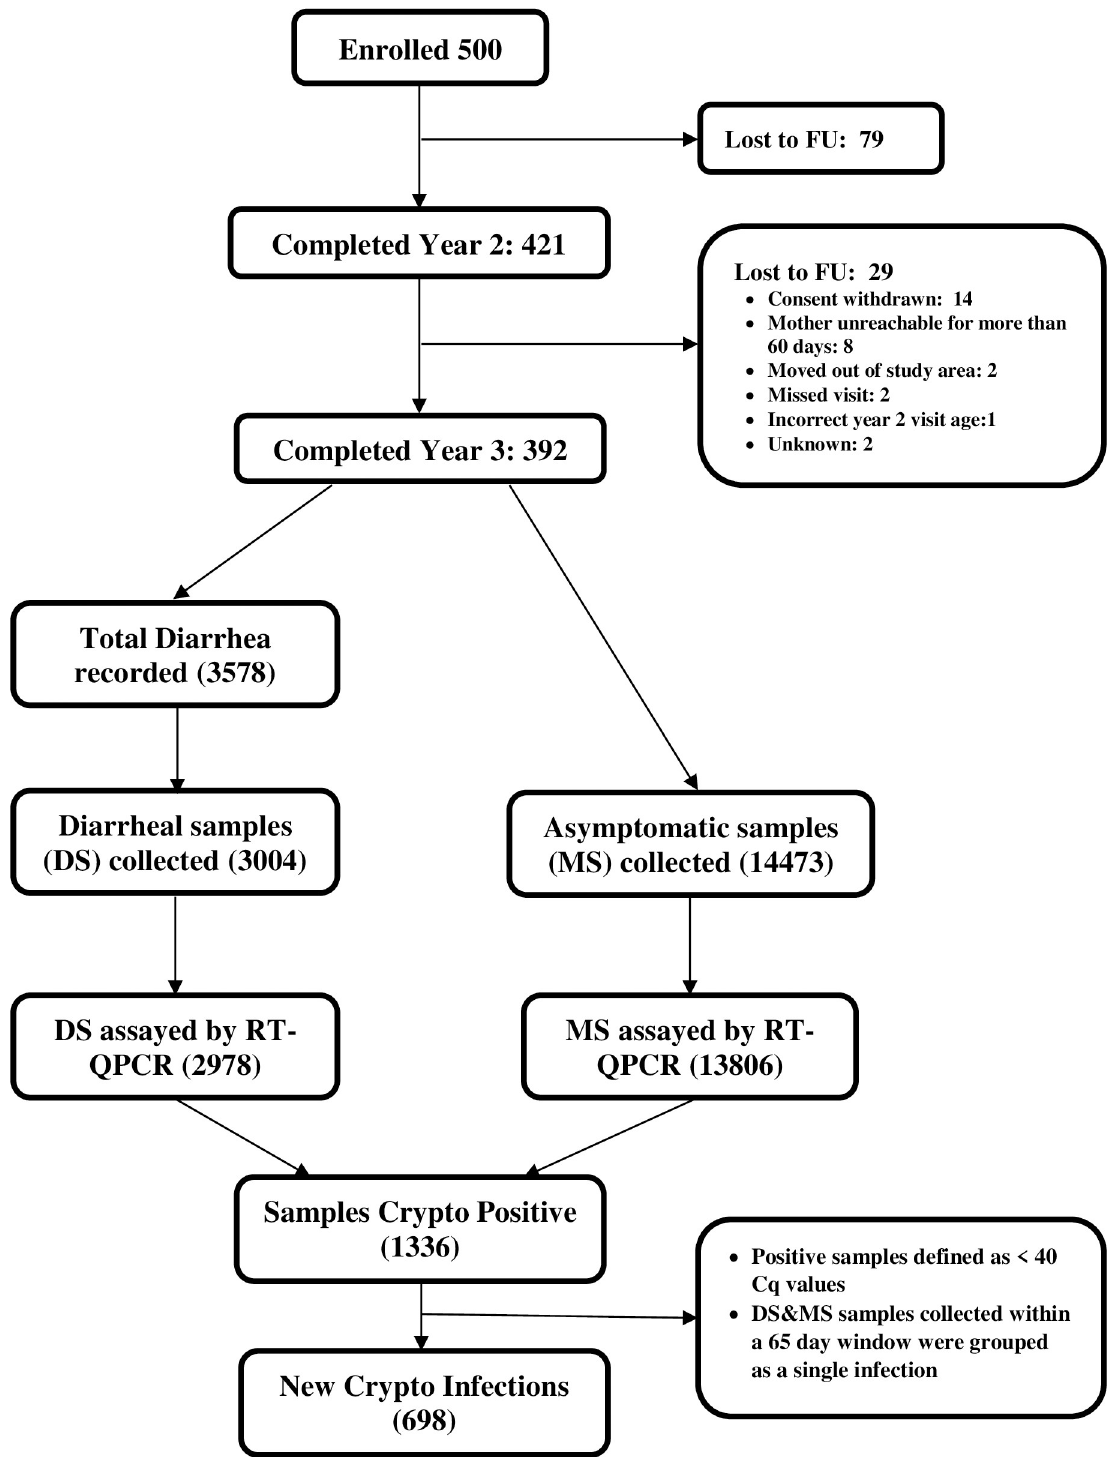
Fig 1. COHORT diagram. Study subjects, collected samples and new infection numbers. Abbreviations: RT-qPCR Real-Time quantitative polymerase chain reaction; DS: Diarrheal Stool samples; FU: Follow-up; MS: Monthly Stool Samples, Cq: Cycle Quantification.